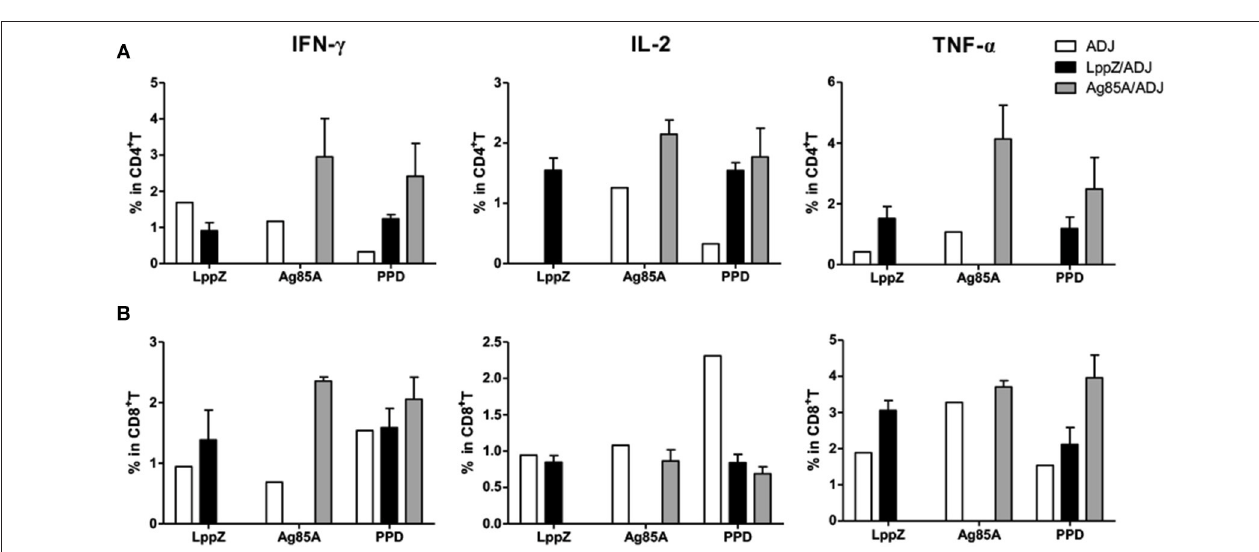
FIGURE 6 | M.tb antigen-specific Th1-type cytokine production in CD4 + or CD8 + T cells from the lungs of virulent H37Rv-challenged mice. Four weeks after bacteria challenge, mice were sacrificed and lymphocytes from the lungs were collected. For ex vivo stimulation, 5 × 10 5 cells from different groups (ADJ, LppZ/ADJ